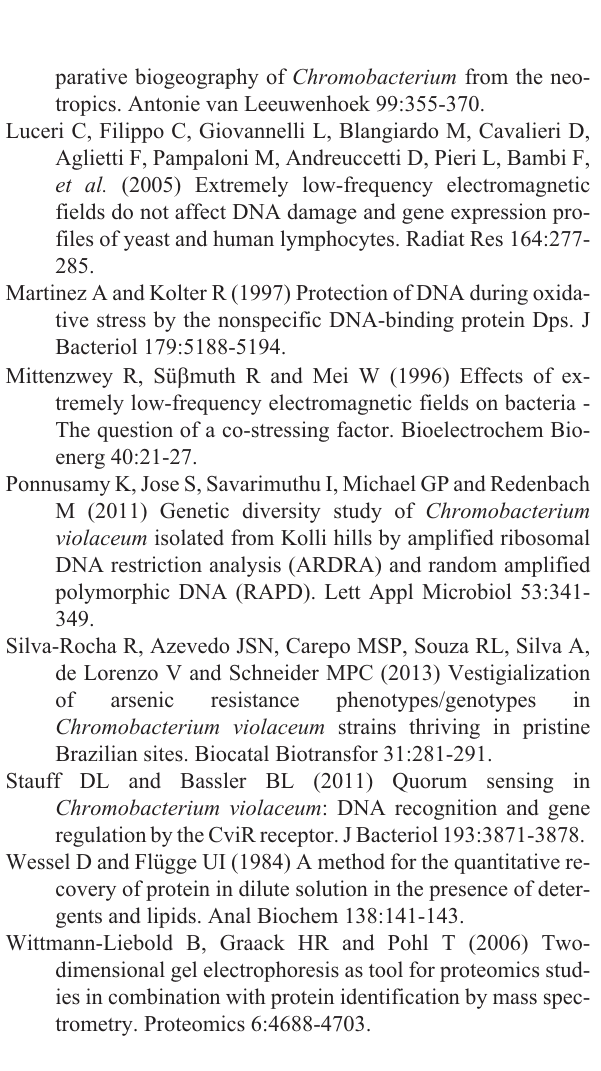
Figure S1 - MS and MS/MS spectra generated for spots 394 (a) and 458 (b). Figure S2 - Cell density and protein concentration of con- trol and exposed